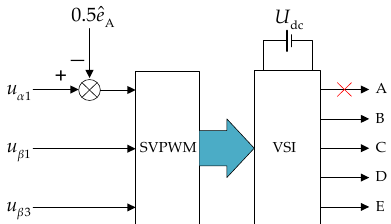
Figure 4. Control diagram of system under A-phase open circuit with feedforward compensation.